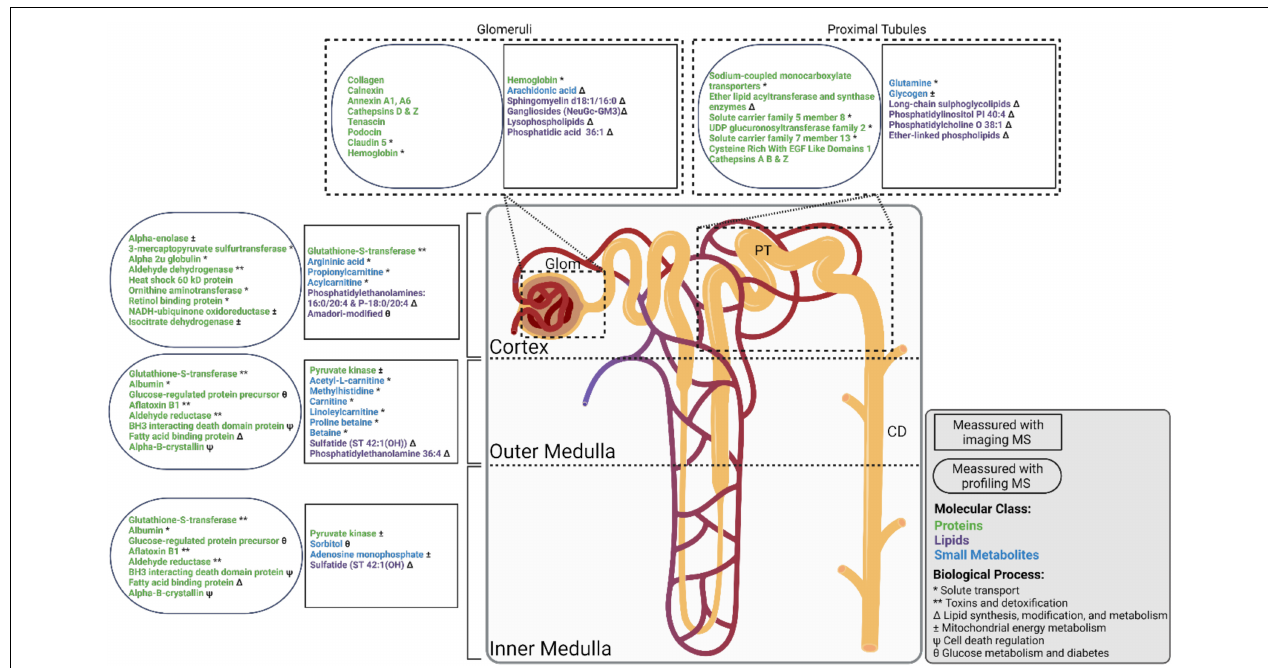
FIGURE 2 | Nephron showing select molecular groups observed in the cortex, outer medulla, inner medulla, glomeruli (Glom), proximal tubules (PT), and collecting ducts (CD). Molecular observations made using imaging mass spectrometry (MS) and profiling MS experiments are shown in rectangles and ovals, respectively. Proteins, small metabolites, and lipids, are shown in green, blue, and purple text, respectively. Biological processes are indicated as follows: * Solute transport, ** Toxins and detoxification, (cid:49) Lipid synthesis, modification, and metabolism, ± Mitochondrial energy metabolism, (cid:57) Cell death regulation, θ Glucose metabolism and